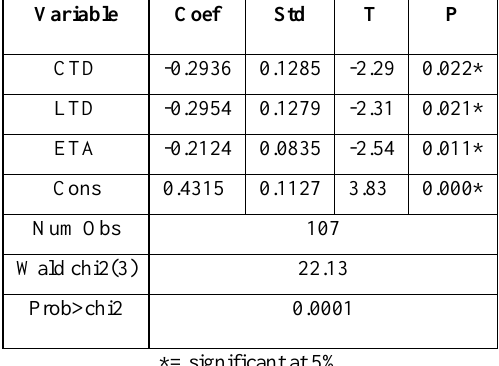
Table 8: Random-Effects GLS Robust Results